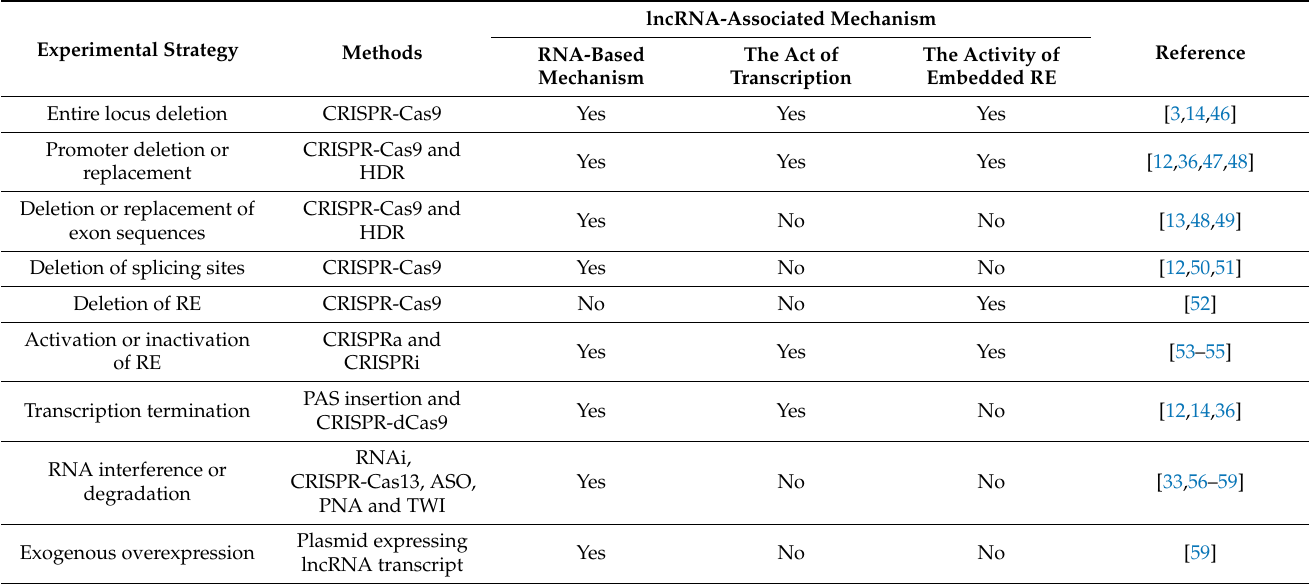
Table 1. Experimental methods to for discriminating the regulatory mechanisms of lncRNA